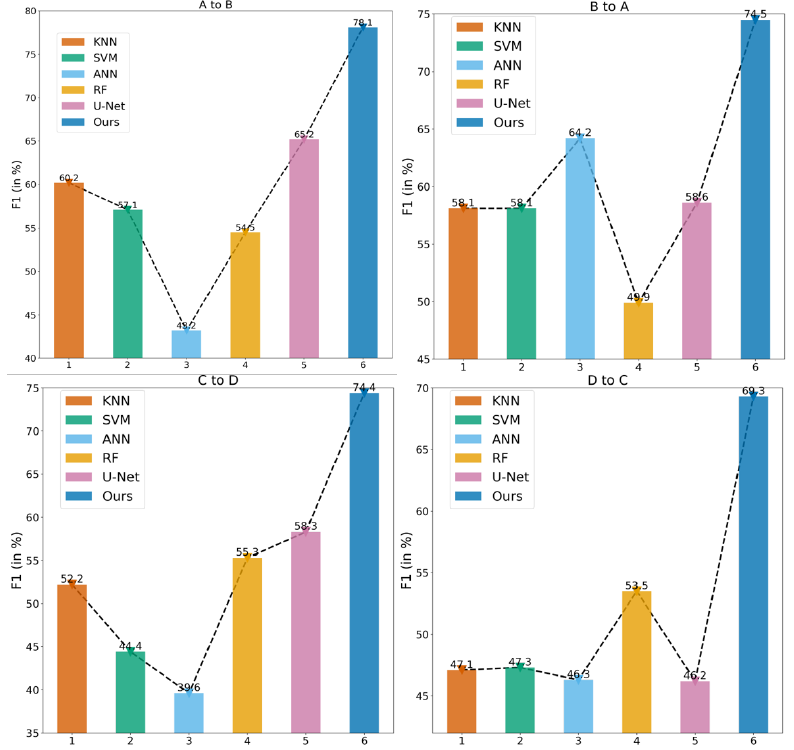
Figure 5. Comparative study results of different